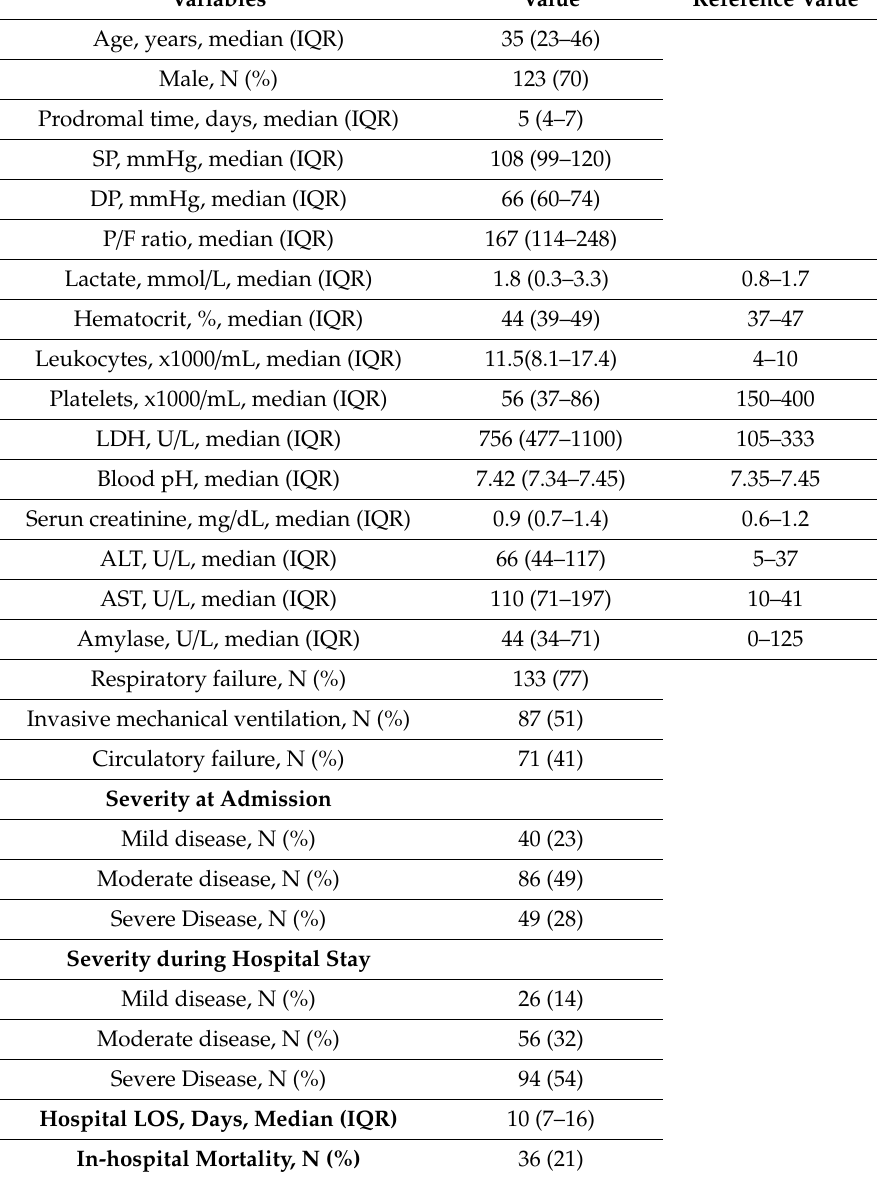
Table 1. Characterization of all patients considered in this study ( N = 175). SP (systolic arterial pressure), DP (diastolic arterial pressure), P / F ratio (arterial oxygen partial pressure to inspired oxygen fraction ratio), LDH (lactate dehydrogenase), ALT (alanine aminotransferase), AST (aspartate aminotransferase). Prodromal time was defined as the number of days with fever before hospital admission. The proportion of patients with mild, moderate and severe disease at admission is presented. Severity during hospital stay is the maximal disease category achieved along the in-hospital course according to the same three categories defined in methods. Hospital length of stay (LOS) and in-hospital mortality are also